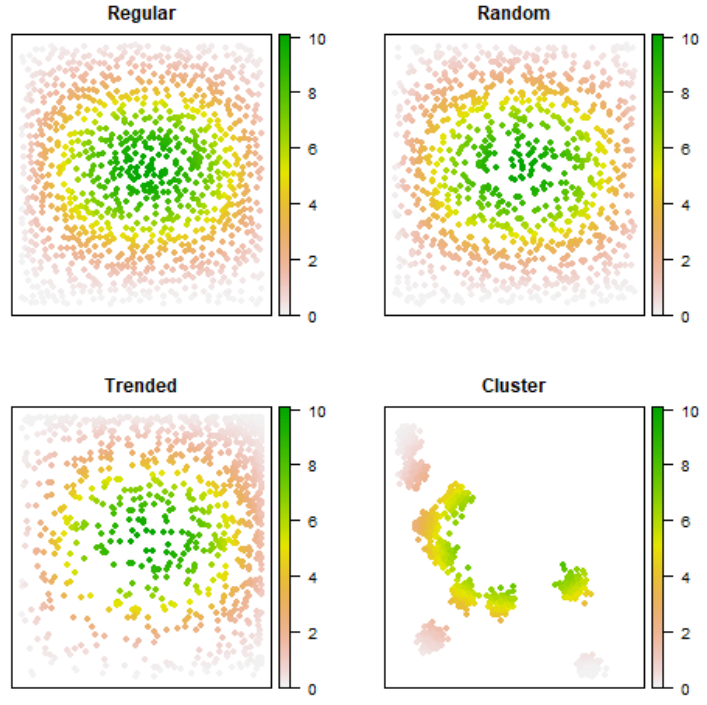
Figure 2. Maps of the largest spatial populations of 1000 points adopted in the